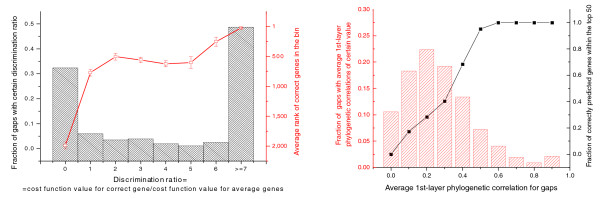
Importance of metabolic neighborhood for the predictive power of the algorithm. (a) Informative and non-informative gaps. About one-third of the gaps did not allow any discrimination between the correct and average genes (represented by bin 0 in the figure), that is, the function value of the correct gene is equal to or smaller than the function value for average genes determined by Equation 2. The red line shows the average rank of correct genes represented in each bin. Genes filling gaps with higher discrimination ratios are ranked higher by the algorithm. (b) The relationship between the rank of a correct enzyme in a gap and the average correlation of first layer genes around the gap. A metabolic gene for a gap with a high average first layer correlation (>0.5) is usually highly ranked by the prediction algorithm (black line) but the fraction of such gaps is small (red bins).